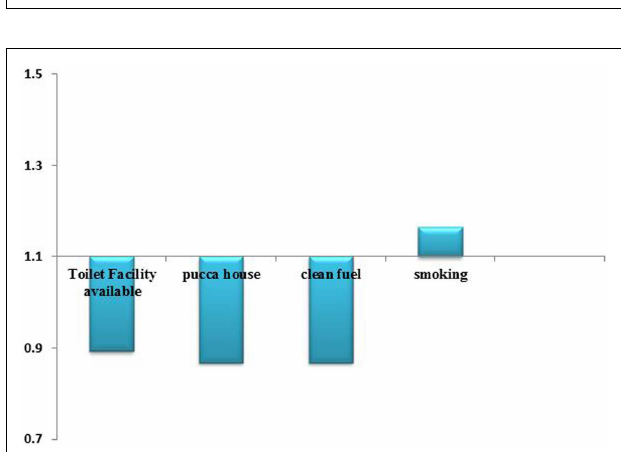
FIGURE 4 | Percentage of children under the age of 5years who had anemia by place of residence according to sex .